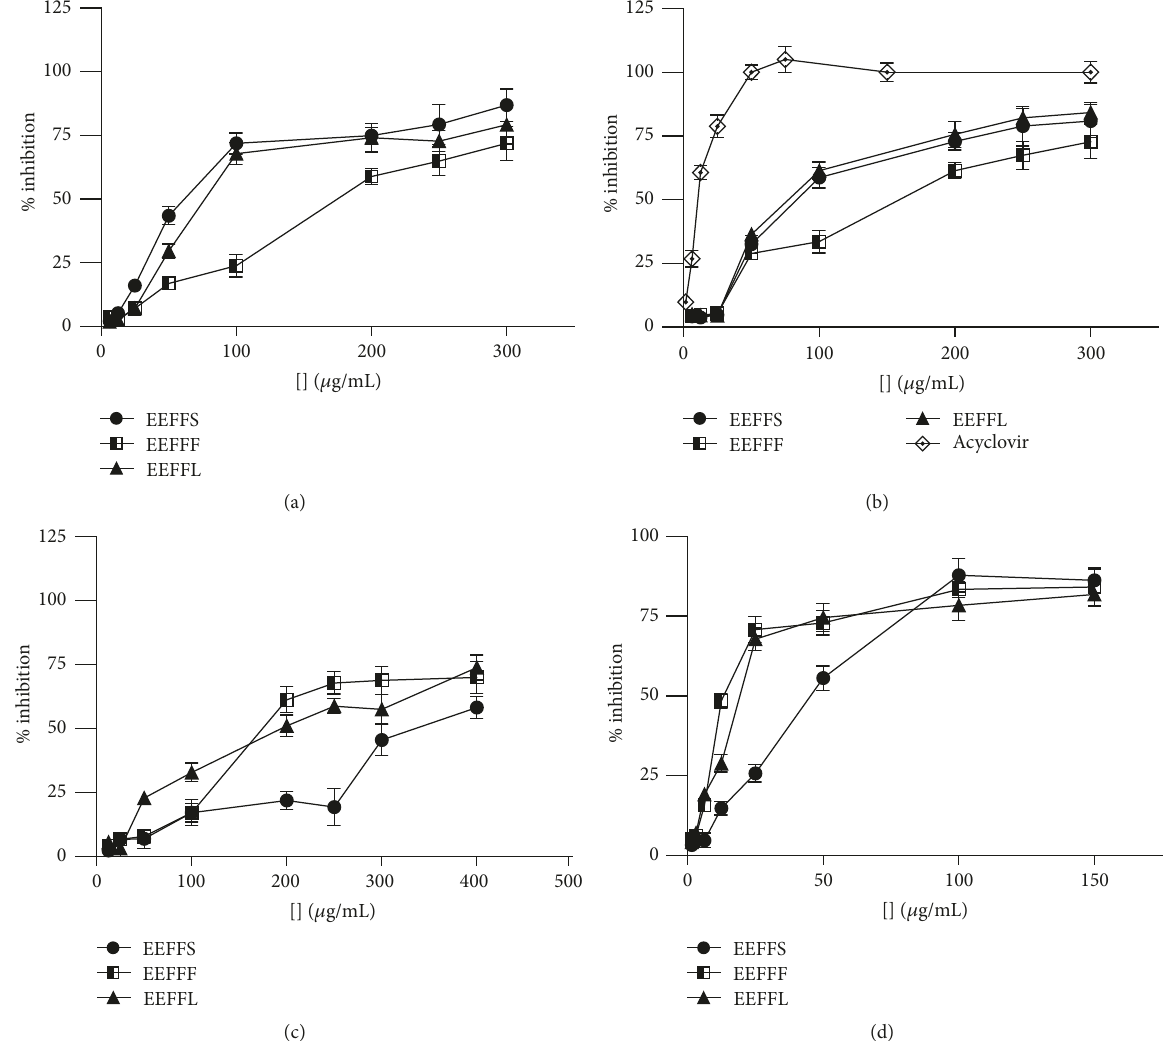
Figure 3: Dose-response curves for antiviral activity of ethanol extracts from Fridericia formosa (a) leaves (EEFFL), stems (EEFFS), and fruits (EEFFF) against VAC-WR; (b) EEFFL, EEFFS, and EEFFF against HSV-1; (c) EEFFL, EEFFS, and EEFFF against EMCV; (d) EEFFL, EEAFS, and EEFFF against